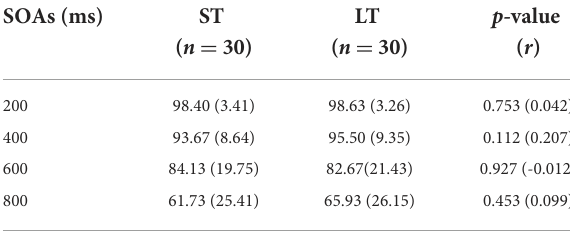
TABLE 3 The accuracy of the Stop trails at different interval times in each group.